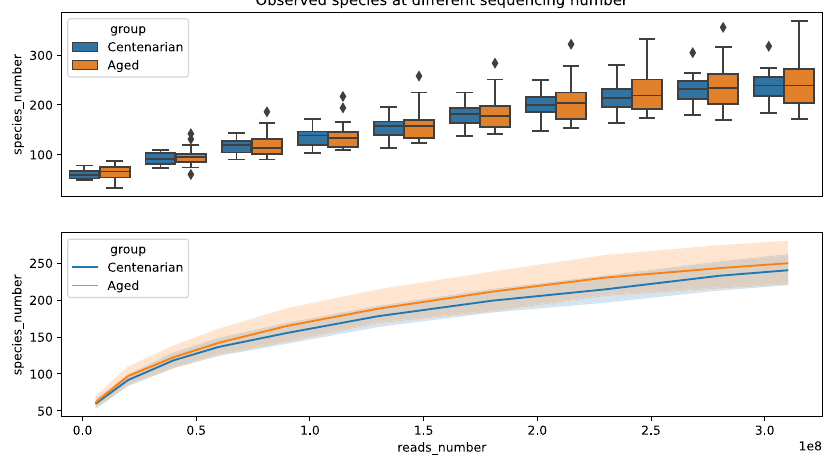
Fig. 6 Rarefaction curve as indicated by Shannon or Simpson index. The upper chart shows the observed species at different sequencing numbers in a box plot format and the lower chart indicates the same thing and plots the data in a line regression format. The number of observed species increases rapidly until the sequencing reads becomes 5e7 and after that, the number of observed species still grows.